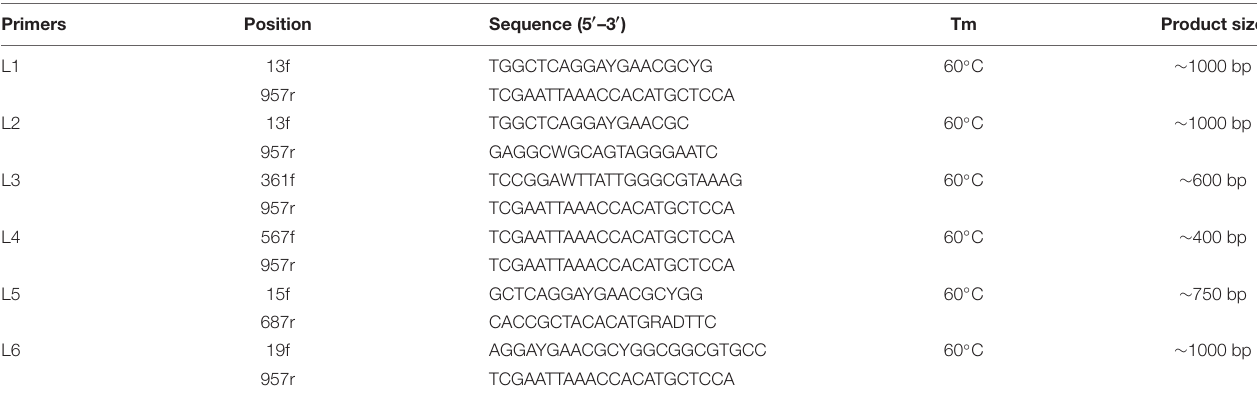
TABLE 2 | Information about the selected lactic acid bacteria primers. Primers